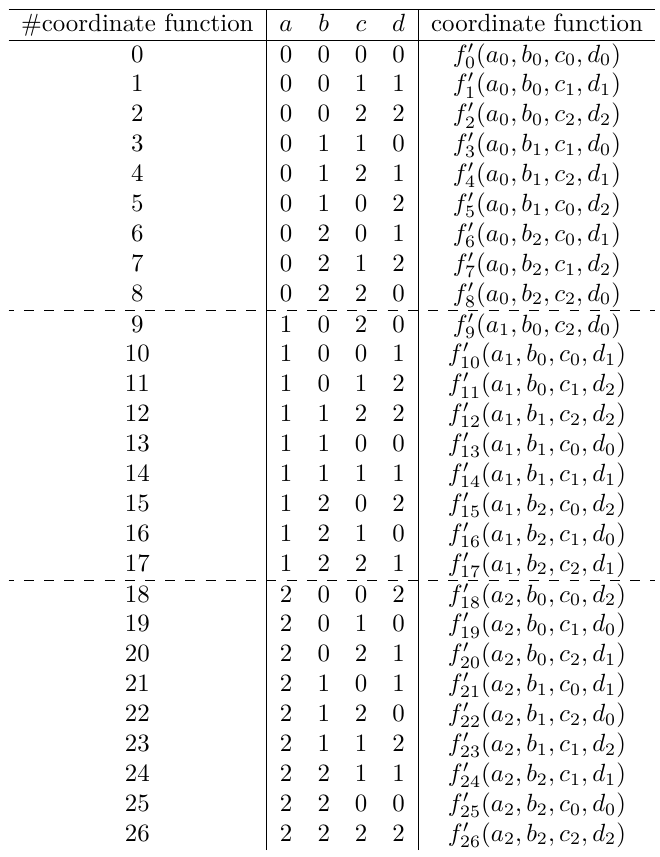
Table 2: A sample index configuration tables, where ⟨ I 0 , I 1 , I 2 , I 3 ⟩ is assigned to ⟨ a, b, c, d ⟩ .